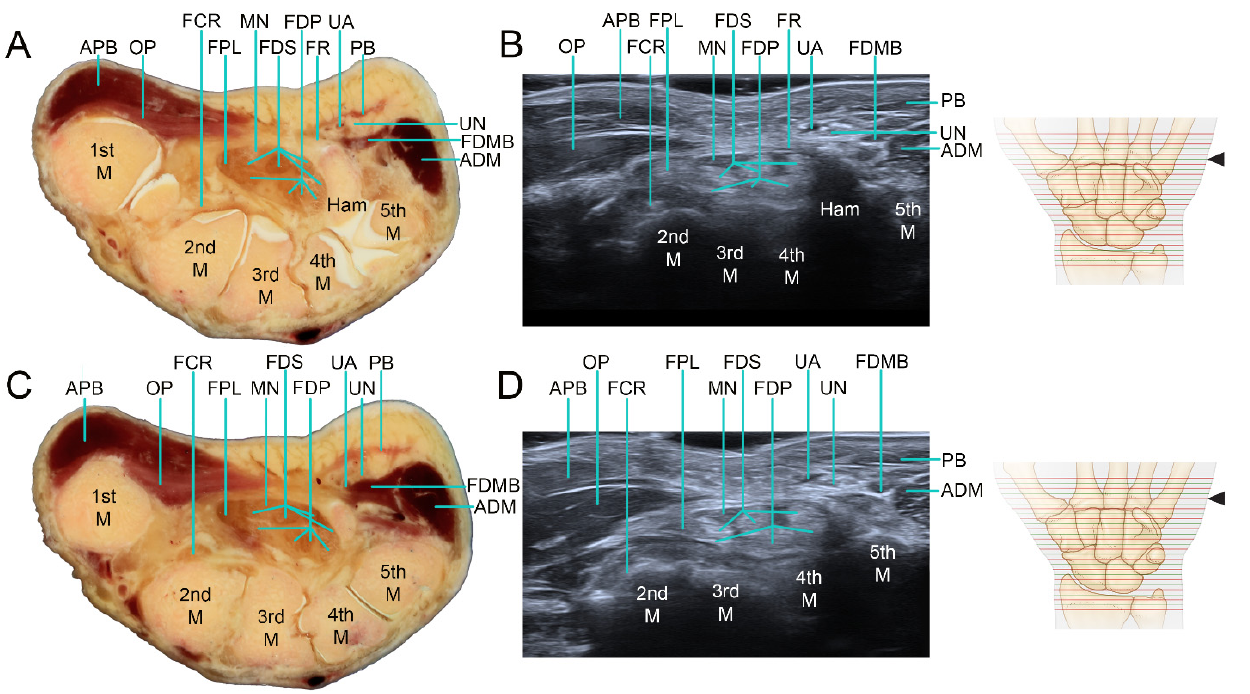
Figure 8. Sectioned images ( A , C ) and corresponding US ( B , D ) images for transverse views at the proximal part of the metacarpal bases. ( A , B ) The distal hook of Ham and the metacarpals are observed. The FR is attached to the apex of the hook of ham. The FDS and FDP tendons are anterior to the second metacarpal, third metacarpal, and fourth metacarpal (4th M) and are radial to the hook of Ham. The FPL tendon is oval-shaped and is just radial to the second FDS and FDP tendons. The APB and OP become thicker and extend to the FR. The MN is between the second and third FDS tendons. The UA and UN are anterior to the hook of Ham, superficial and radial to the FDMB, and deep to the PB. ( C , D ) At a more-distal level, the proximal second metacarpal, third metacarpal, fourth metacarpal, and fifth metacarpal (5th M) bases articulate with the adjacent metacarpals. The thenar (APB and OP) and hypothenar (FDMB and ADM) muscles become thicker. The FCR tendon is on the anterior surface of the second metacarpal base. The MN is between the second and third FDS tendons. The UA and UN are between the PB and FDMB. Arrowheads in the schematics indicate the levels of the wrist scanned by the US transducer.